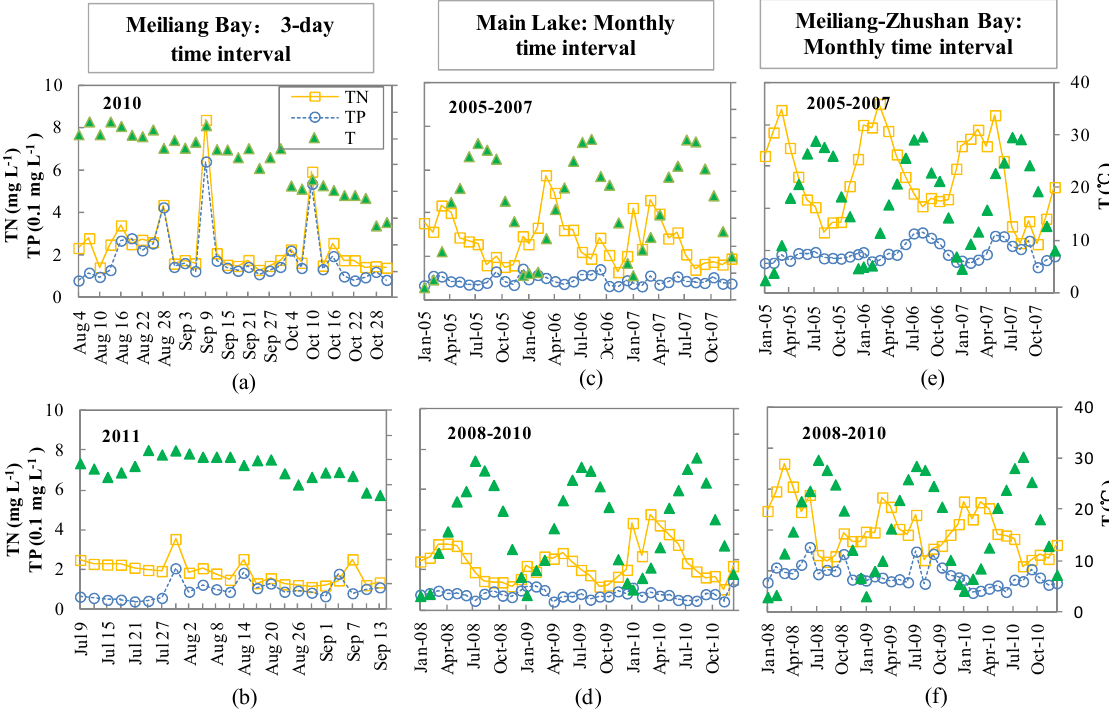
Figure 2. Temporal variations of nutrients (total nitrogen (TN), and total phosphorus (TP)), water temperature (WT) and ambient air temperature (AT): ( a , b ) Meiliang Bay, three-day measurement intervals; ( c , d ) main lake, monthly measurement intervals; and ( e , f ) Meiliang-Zhushan Bay, monthly measurement intervals. WT is shown in ( a , b ), and AT in ( c ) through ( f ) and designated T in